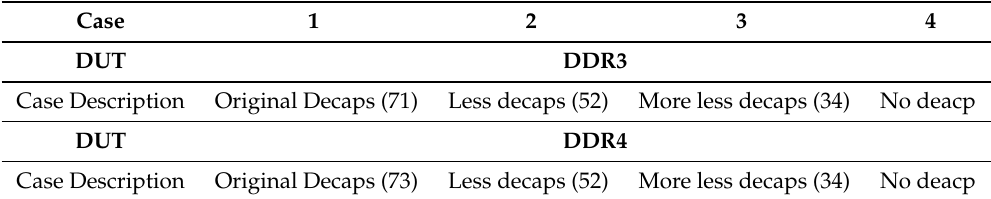
Table 7. ESD DOE simulation cases to analyze the change in number of decaps on coupled ESD noise (“(#)” shows the number of used decaps for each DOE